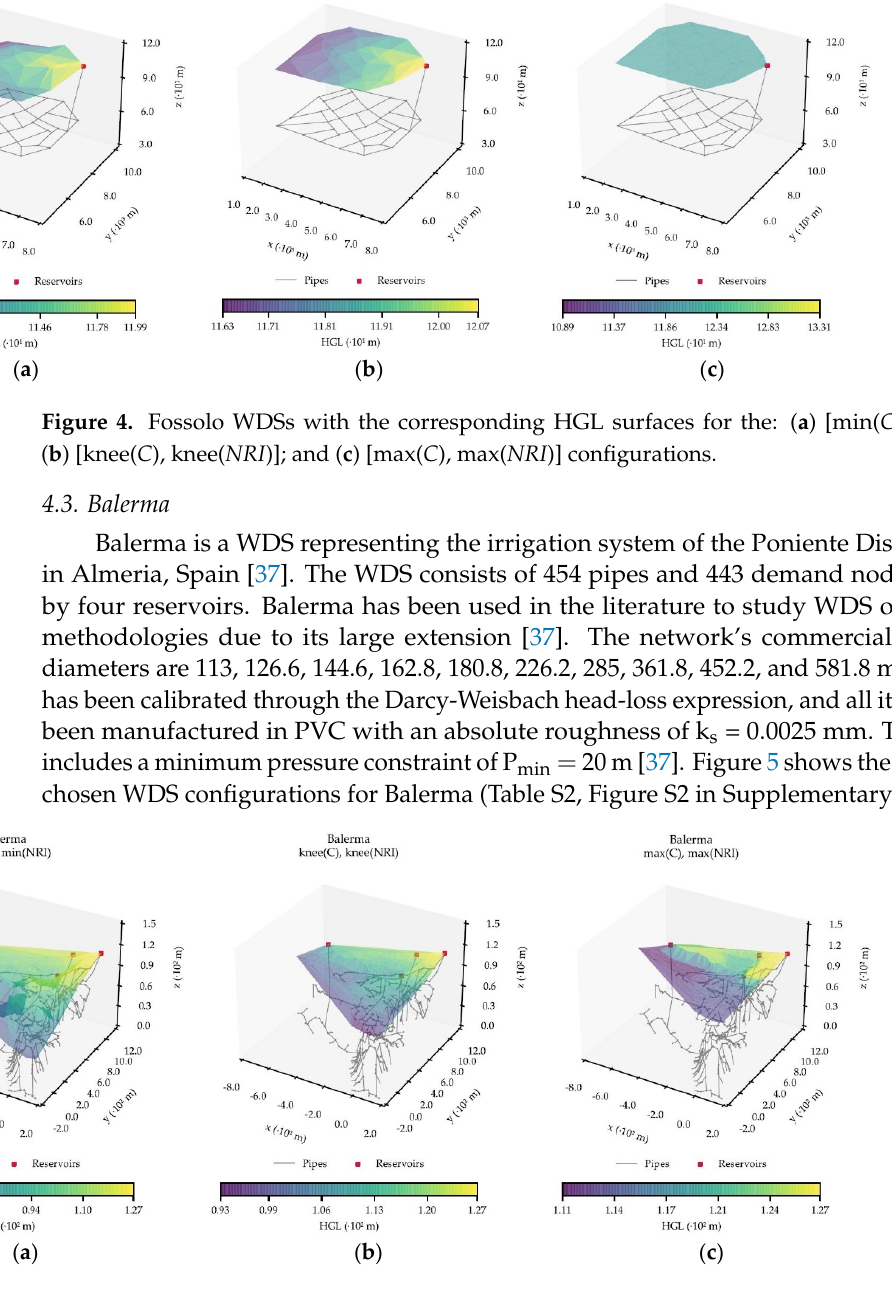
Figure 3. Hanoi WDS with the corresponding HGL surfaces for the: ( a ) [min( C ), min( NRI )]; ( b ) [knee( C ), knee( NRI )]; and ( c ) [max( C ), max( NRI )] configurations. 4.2. Fossolo